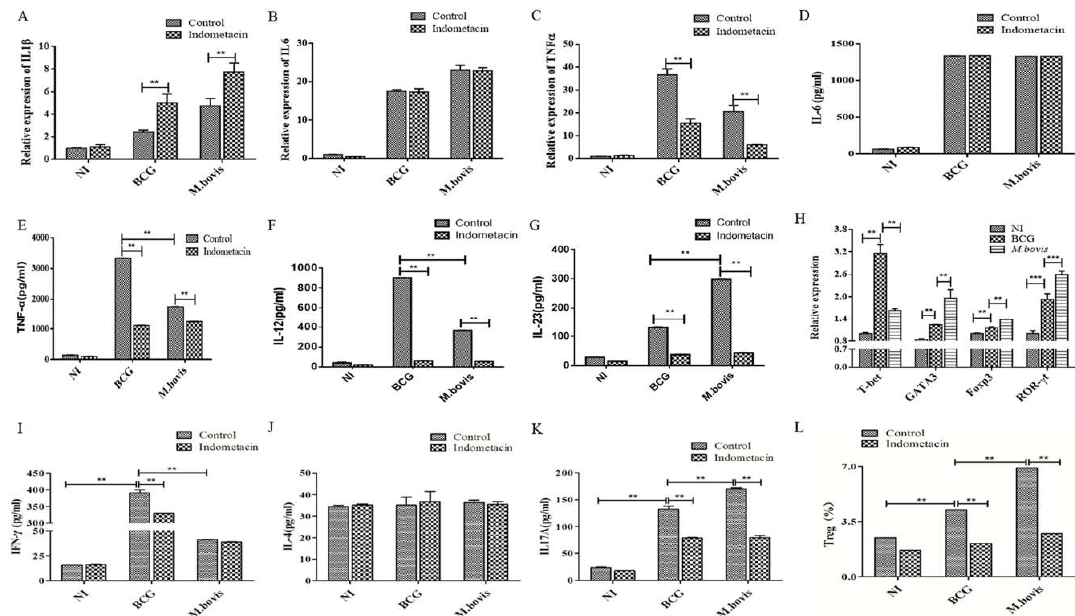
Figure 4. The effect of the COX inhibitor indomethacin on the differentiation of CD4 + T cell subsets stimulated by mycobacteria-infected DCs. DCs were infected with BCG and M. bovis for 24 h at a multiplicity of infection (MOI) of 10, and 50 mg / mL indomethacin was added independently. The relative transcription of IL-1 β ( A ), IL-6 ( B ), and TNF- α ( C ) in DCs was measured with real-time RT-PCR. The concentrations of IL-6 ( D ), TNF- α ( E ), IL-12 ( F ) and IL-23 ( G ) in DCs were measured with commercial ELISA kits at 24 h post-infection (PI). The DCs infected with M. bovis and BCG for 24 h at an MOI of 10 were co-cultured with naïve CD4 + T cells for 24 h. The DCs without mycobacteria infection / naïve CD4 + T cells ( NI ) were employed as a negative control. Infected group: CD4 + T cells co-cultured with an M. bovis - or BCG-infected DC culture. Inhibition group: COX inhibitor indomethacin was added to the culture. ( H ) Transcriptional levels of T-bet, GATA3, Foxp3, and ROR- γ t were measured with qRT-PCR. The secretion proteins of IFN- γ ( I ), IL-4 ( J ), and IL-17A ( K ) were measured with ELISA kits. ( L ) Proportion of Treg (CD25 + Foxp3 + ) was measured with flow cytometry. The data are shown as the mean ± SD of three replicates, where * represents p < 0.05 and ** represents p <